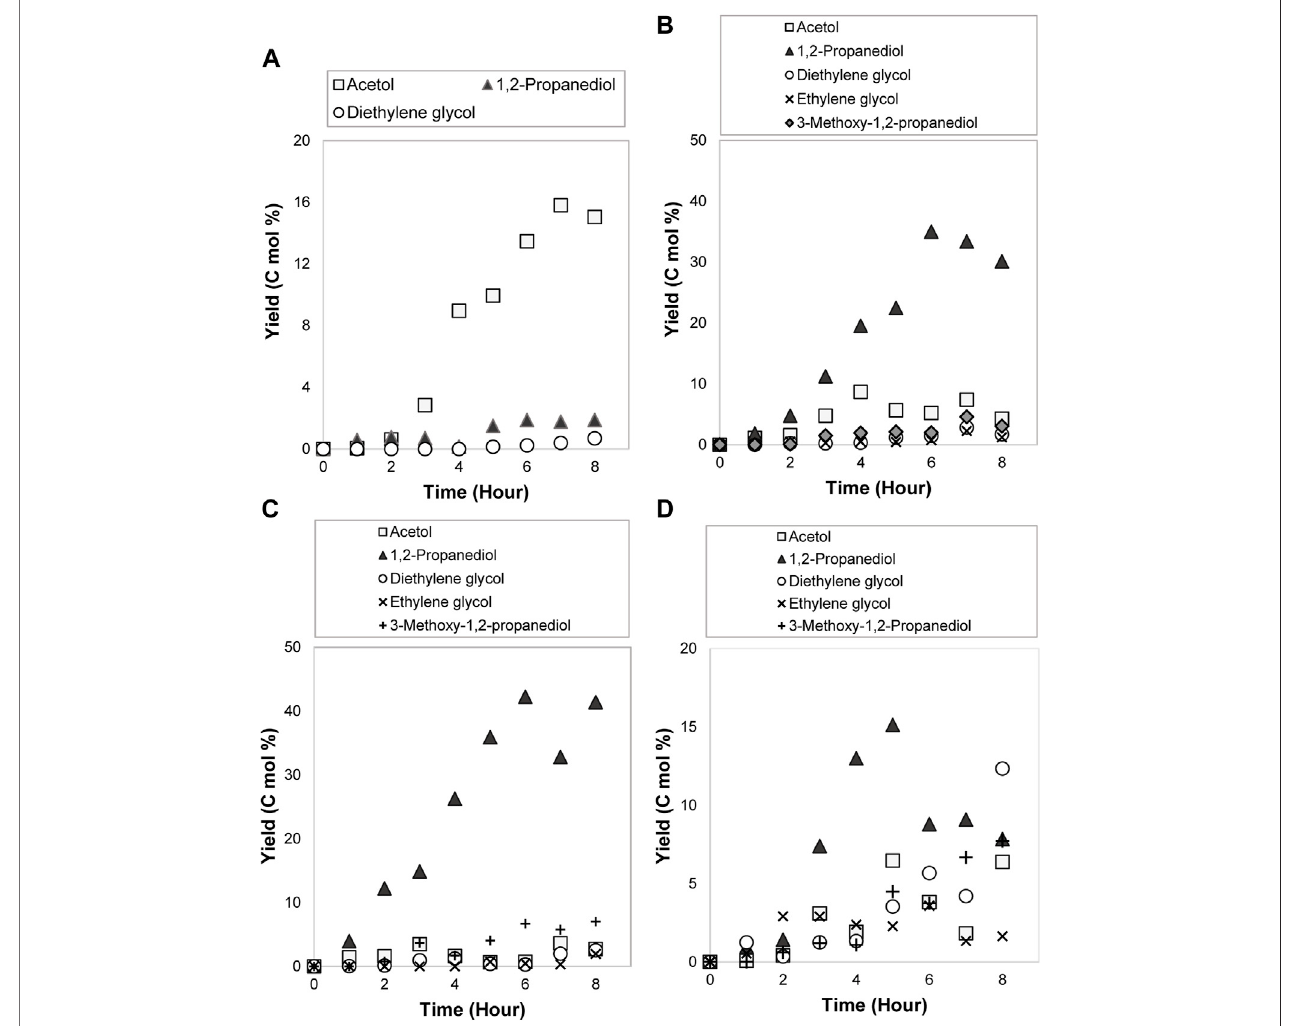
FIGURE 10 | Products distribution at (A) 0.07 A/cm 2 , (B) 0.14 A/cm 2 , (C) 0.21 A/cm 2 , and (D) 0.28 A/cm 2 of current densities during 3.0 mol/L of glycerol electrocatalytic reduction at 353